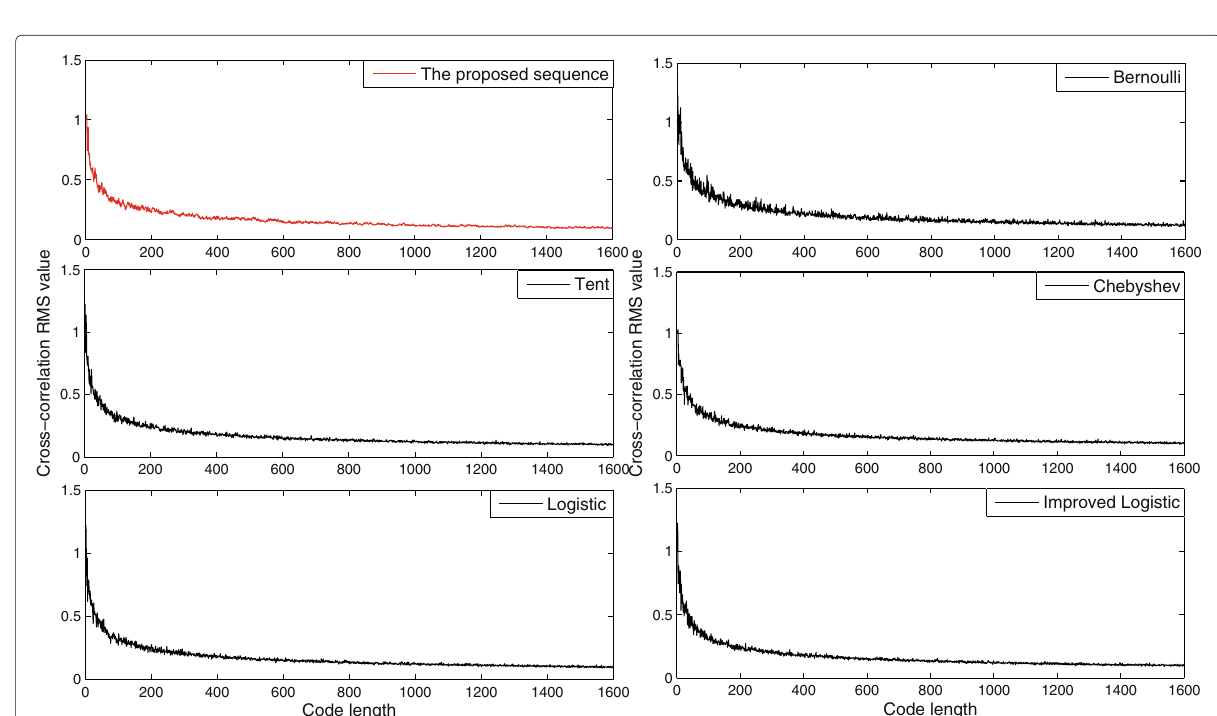
Fig. 6 RMS value of cross-correlation for six chaotic